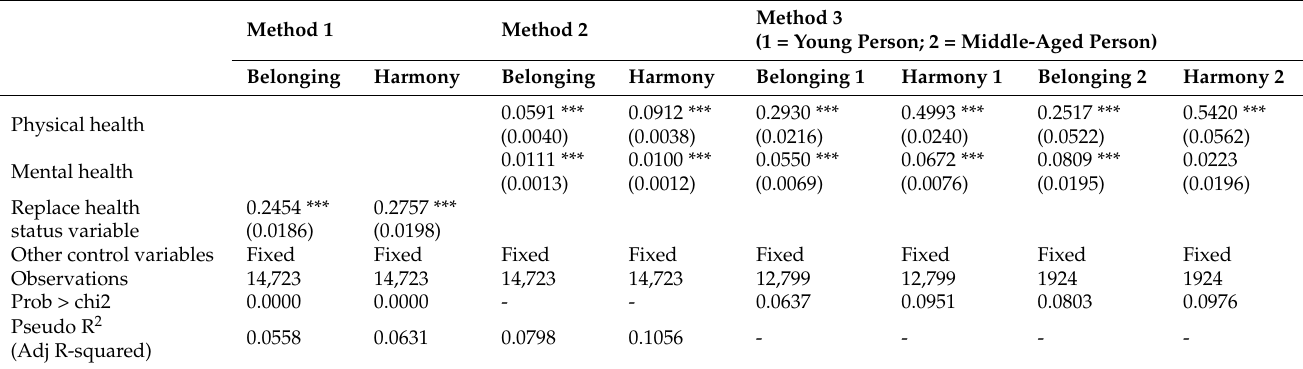
Table 5. Results of robust